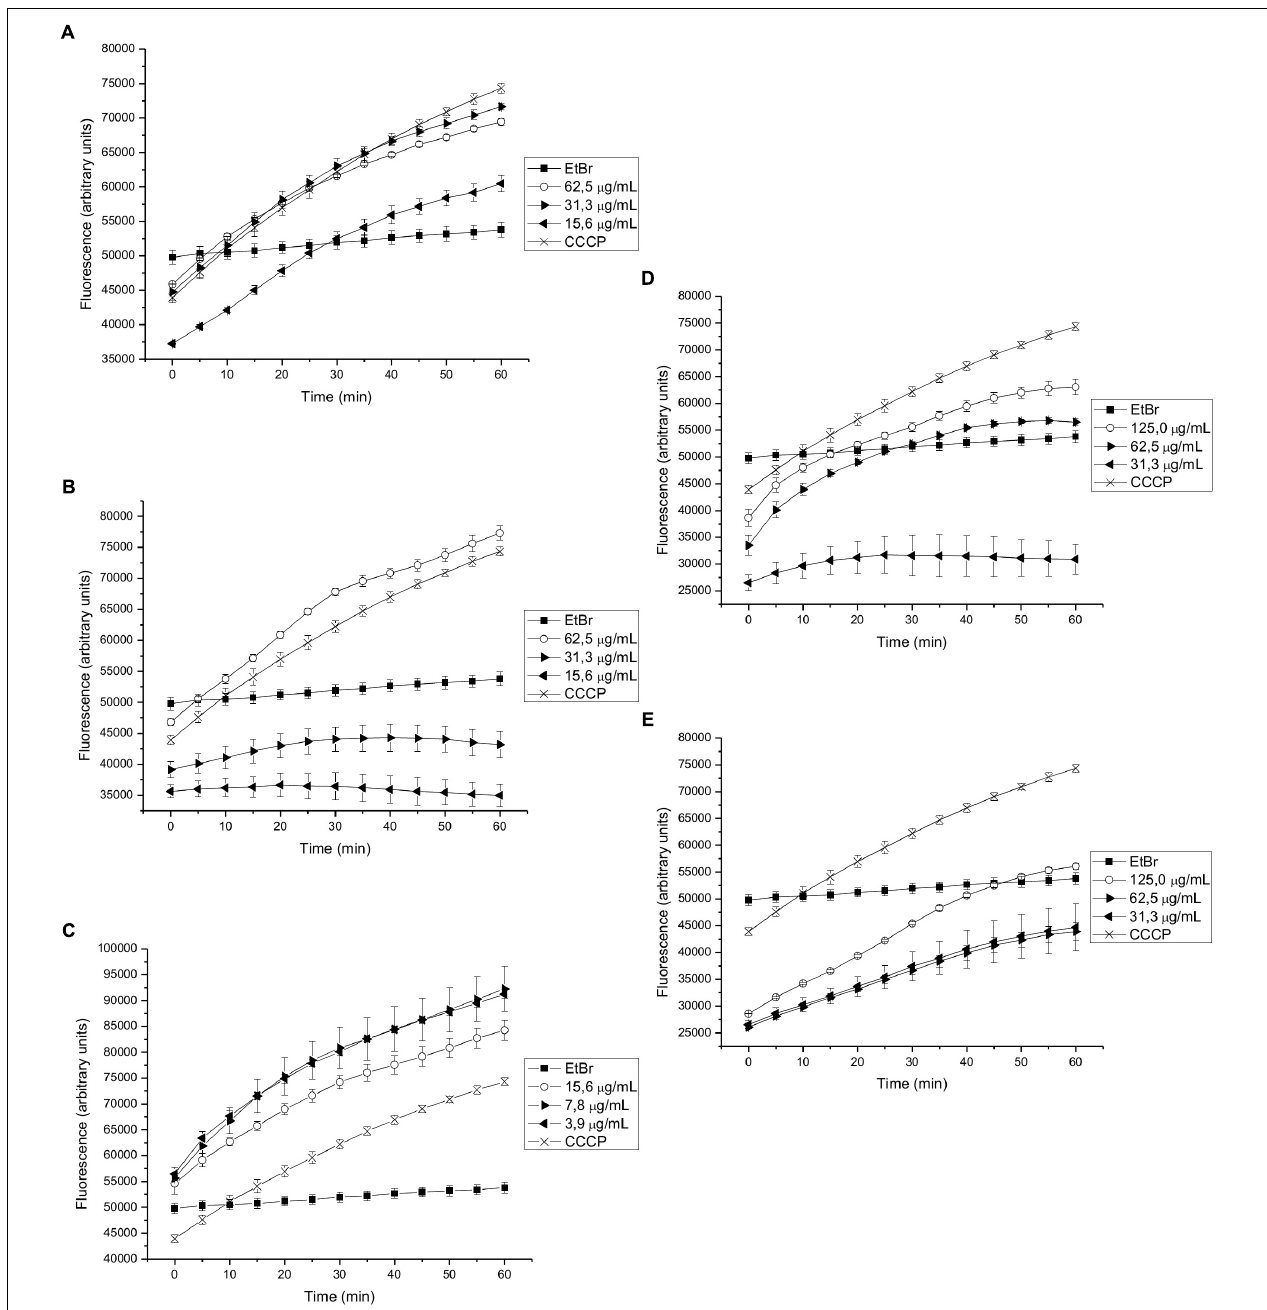
FIGURE 2 | Effect on the intracellular accumulation of ethidium bromide of (A) DCME extract, (B) epi -cubenol (4), (C) 15-copaenol (6), (D) 15-copaenal (6OX), and (E) 15-copaenyl acetate (6AC) in K2378 ( norA++ ) strain. The bacteria were exposed to 2.0 µ g/mL of EtBr at 37 ◦ C for a period of 1 h in the presence of glucose. CCCP (1.25 µ g/mL) was used as inhibitor